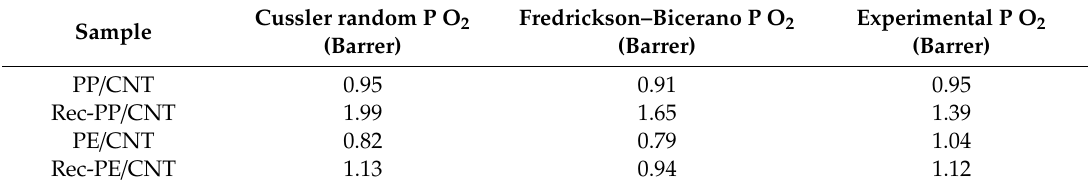
Table 1. Theoretical prediction of